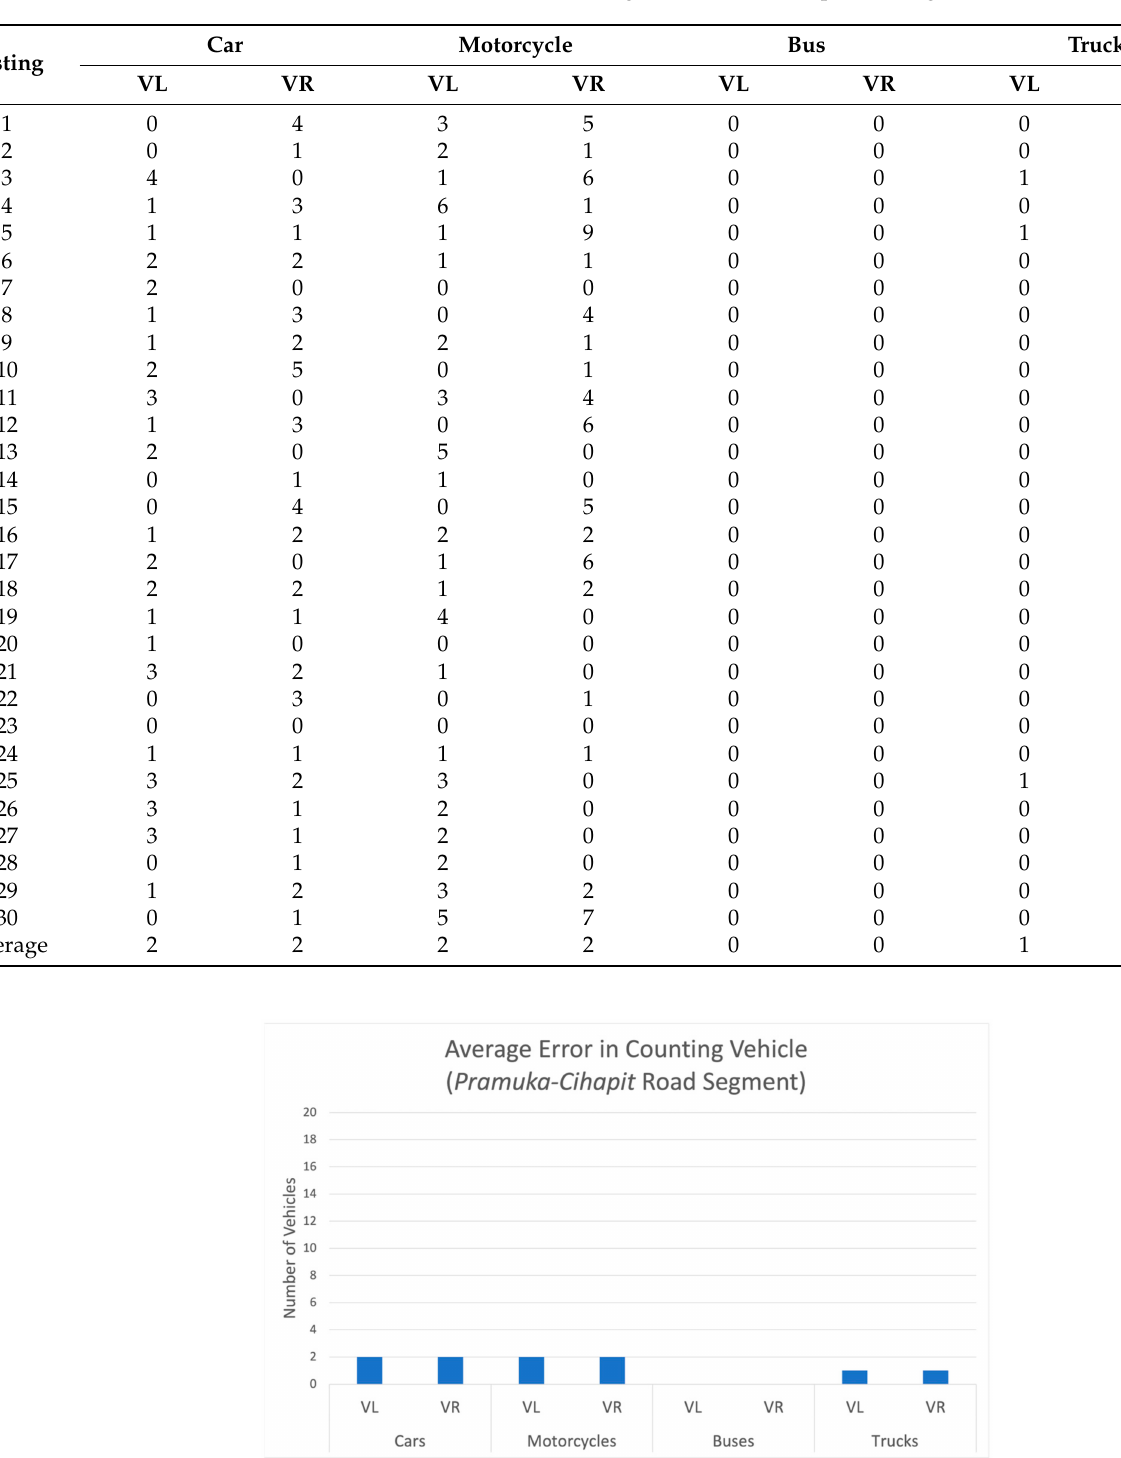
Table 8. Error rate in vehicle counting on Pramuka–Cihapit road segment.